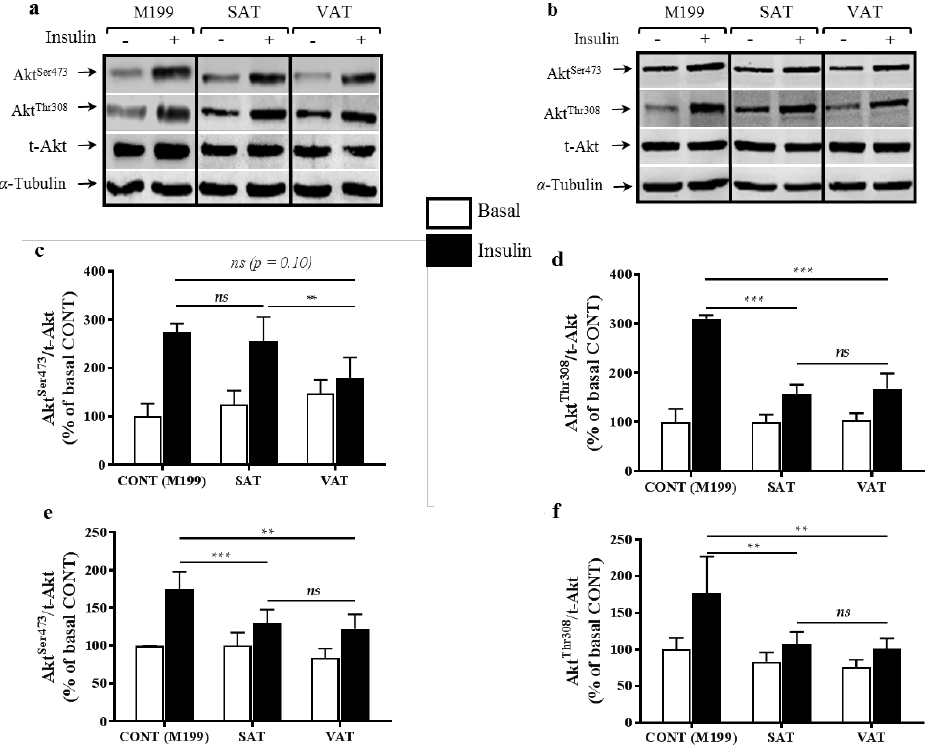
Figure 1. Human skeletal myotubes were incubated for 24 h with either control M199 or secretion media from visceral adipose tissue (VAT) or subcutaneous adipose tissue (SAT) of obese men and women. Myotubes were then stimulated acutely with insulin (100 µU/well, 10 min). Total cell lysates (20 µg/lane) were resolved by 10% sodium dodecyl sulfate-polyacrylamide gel electrophoresis (SDS-PAGE) and immunoblotted for total protein kinase B (t-Akt), Akt Ser473 , Akt Thr308 , and α-tubulin. Representative blots for muscle cells incubated with SAT and VAT media from one male donor ( a ) and one female donor ( b ) are shown. All phosphorylated Akt data were normalized to t-Akt and are expressed relative to the basal control (CONT) M199 value. Data are mean values ± standard error of the mean (SEM) of 10 different men ( c , d ) and 17 women ( e , f ) donors for SAT and VAT samples. **, ***, and “ns” indicate p < 0.01, p < 0.001, and not significant, respectively, for comparisons between insulin-stimulated Table 1 : Proteins detected in visceral adipose tissue (VAT) and subcutaneous adipose tissue (SAT) secretion media from men and women.